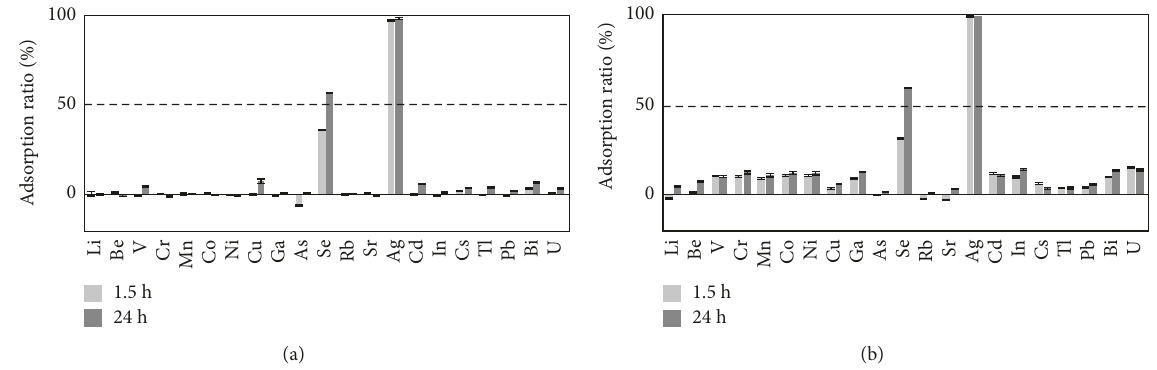
Figure 4: Metal adsorption from multielement solution C with hydrophilic sulfur-containing adsorbents 1 (a) and 2 (b) (feed molar ratio of [C S]/[total metal] 4.5/1). (cid:31) (cid:31)